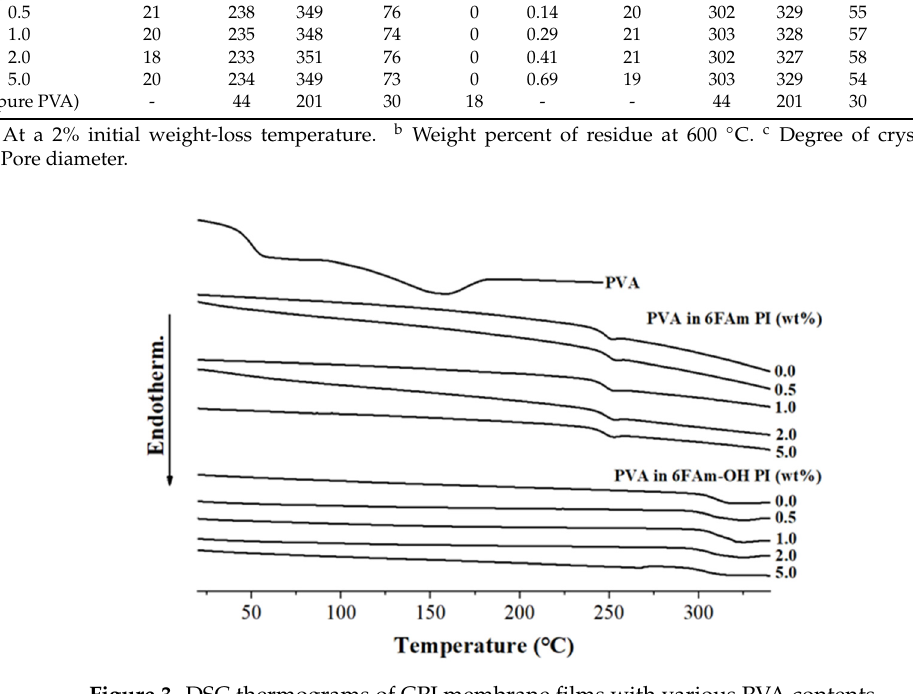
Figure 3. DSC thermograms of CPI membrane films with various PVA contents.